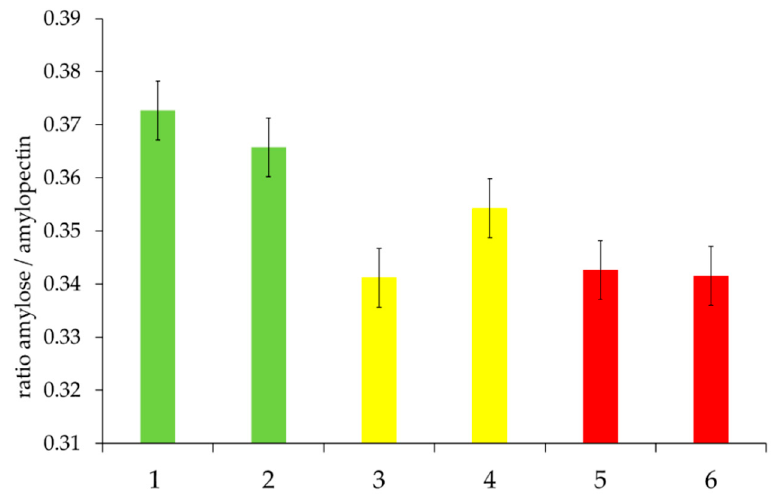
Figure 2. Ratio of amylose and amylopectin in the selected rye flour samples, depending on “good” to “medium” to “poor” baking quality and the corresponding falling number (FN) within the individual baking quality classes (here: first samples were always assigned the lower FN and second samples the higher FN). Sample description: see Table 1. Bars represent the mean value of two replicates; error bars represent the confidence interval.